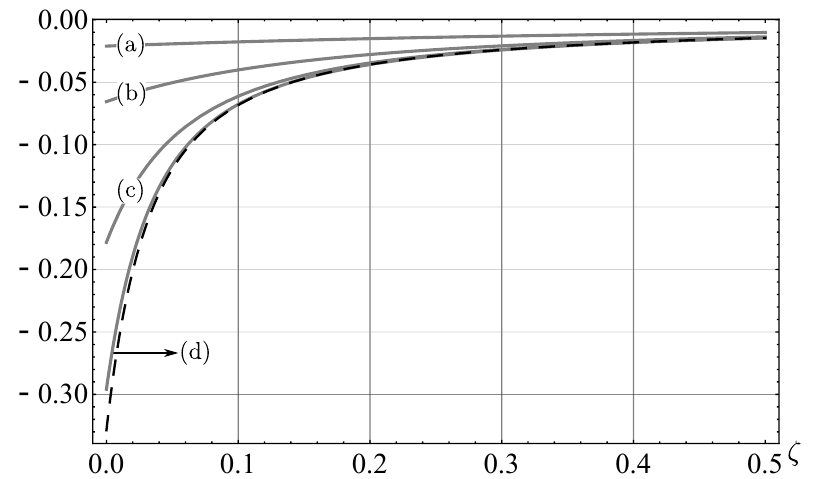
Figure 1. Condensation of the effective potentials (16) onto the saturation curve (19) ( Z = 1). All potentials, given in units of the electron rest energy Mc 2 , are functions of the distance ζ = z /¯ λ C and are labeled by the values of magnetic fields of the following amplitudes: ( a ) B = 10 5 ( b ≈ 5.3), ( b ) B = 10 6 ( b ≈ 5.3 × 10), (c) B = 10 7 ( b ≈ 5.3 × 10 2 ), and ( d ) B = 10 8 ( b ≈ 5.3 × 10 3 ). Their limiting values at z = 0, are, approximately, − 0.0211 for ( a ), − 0.0656 for ( b ), − 0.1782 for ( c ), and − 0.2958 for ( d ).